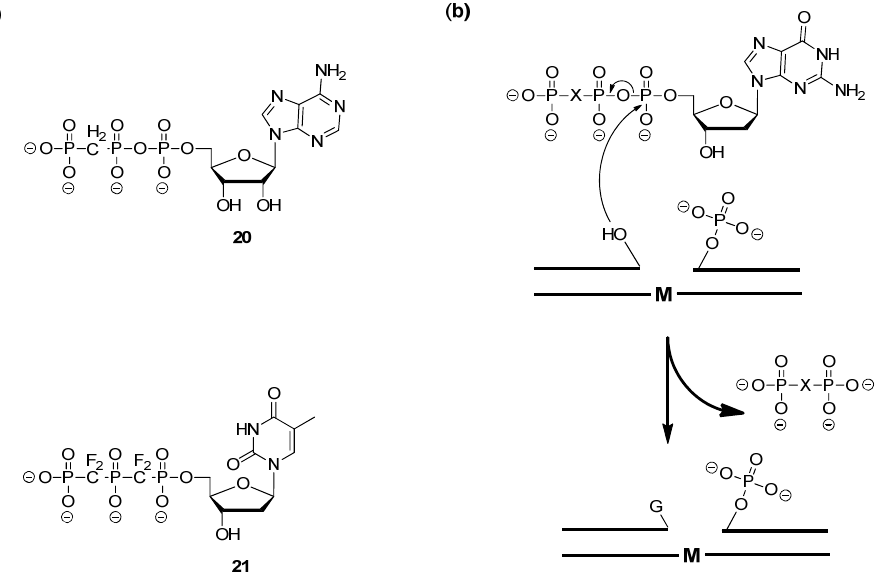
, CHF, CF , CCl , or O; M = C or T) 2 2 2